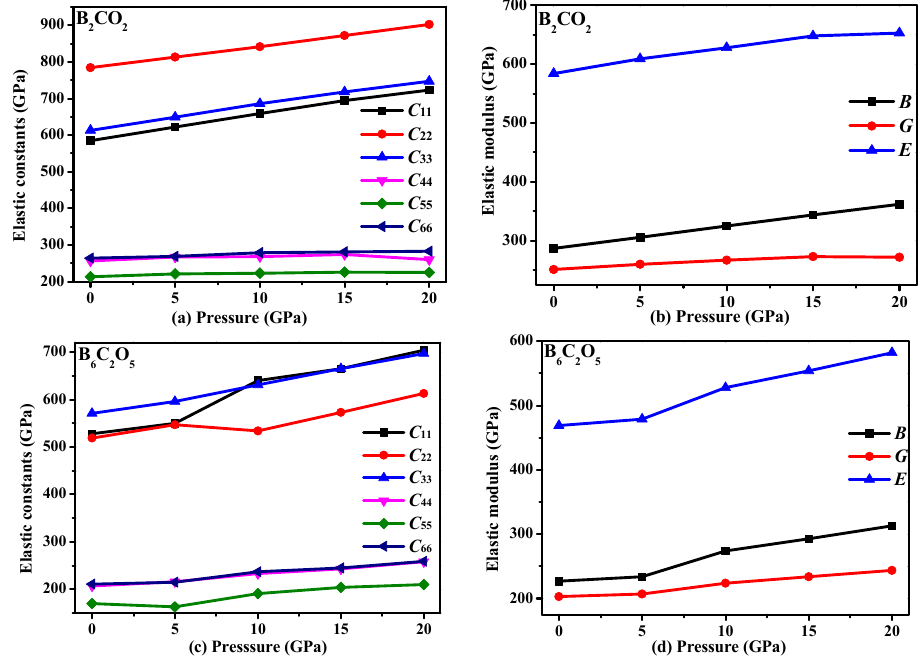
Figure 4. Elastic constants (a) and elastic modulus (b) as functions of pressure for B 2 CO 2 ; and Elastic constants (c) and elastic modulus (d) as functions of pressure for B 6 C 2 O 5 .